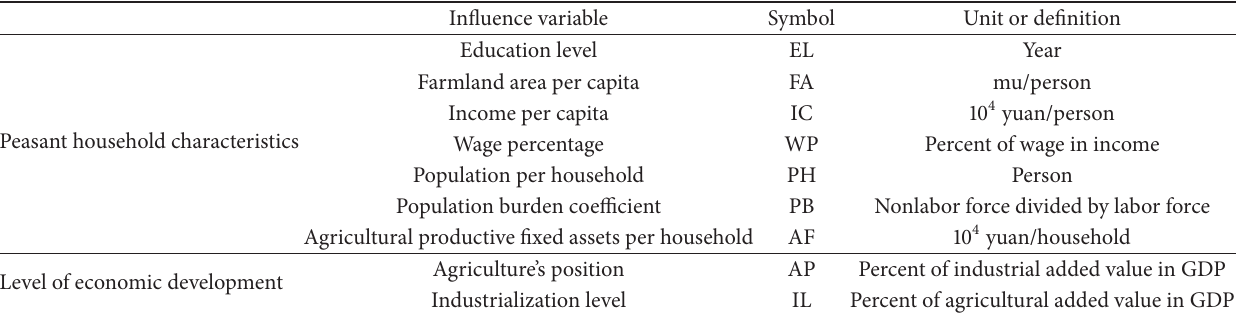
Table 6: Influence variables used in Tobit model.